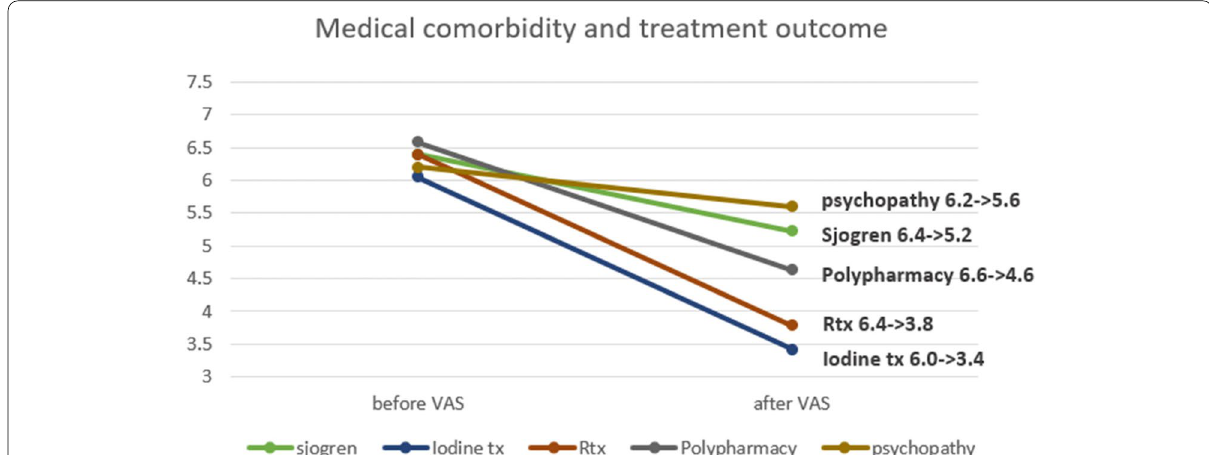
Fig. 11 Correlation of VAS scale and medical comorbidity. Reactivity of treatment differs from the type of medical comorbidity of